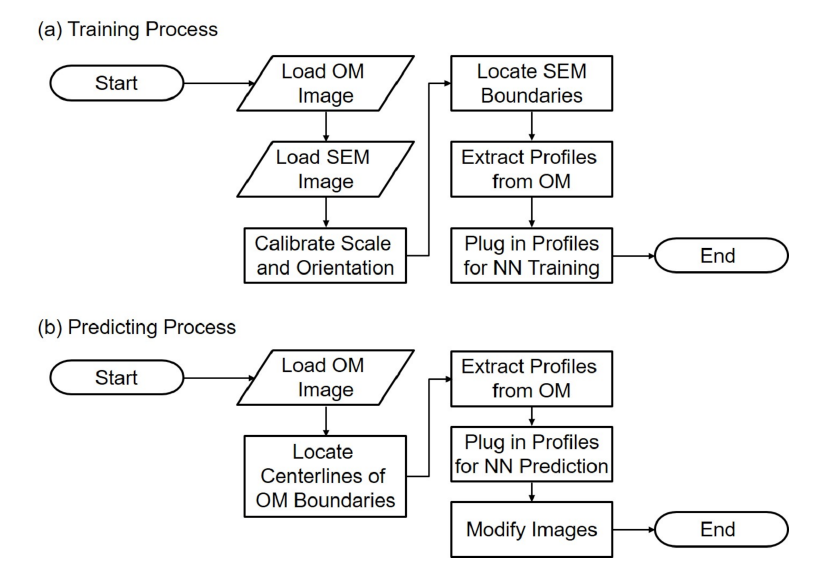
Figure 2. The flowcharts of the proposed method of ( a ) training process and ( b ) predicting process.